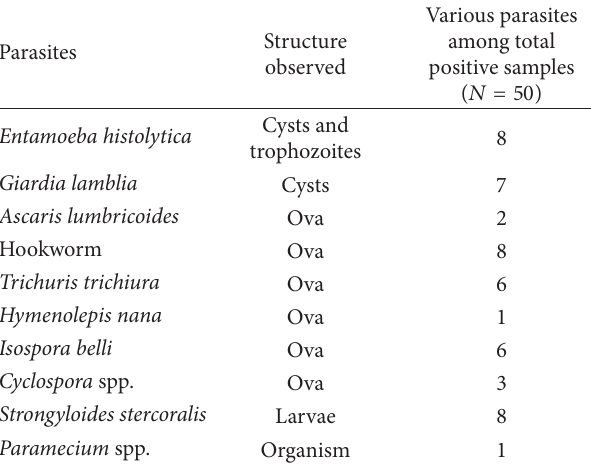
Table 1: Total numbers of various intestinal parasites observed by different wet mounts techniques of faecal